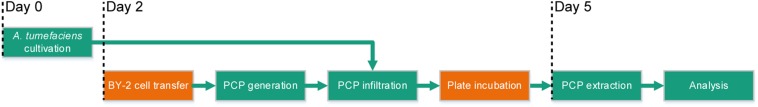
Process flow of the automated PCP process for high-throughput screening applications. The green boxes show the steps of the process that were automated (cultivation of A. tumefaciens, PCP generation and infiltration, PCP extraction and analysis) and the orange boxes show the steps that required manual intervention (BY-2 cell transfer and plate incubation after infiltration) although these steps should be easy to automate at a later stage. Days 0–5 indicate the chronology of the subroutines.